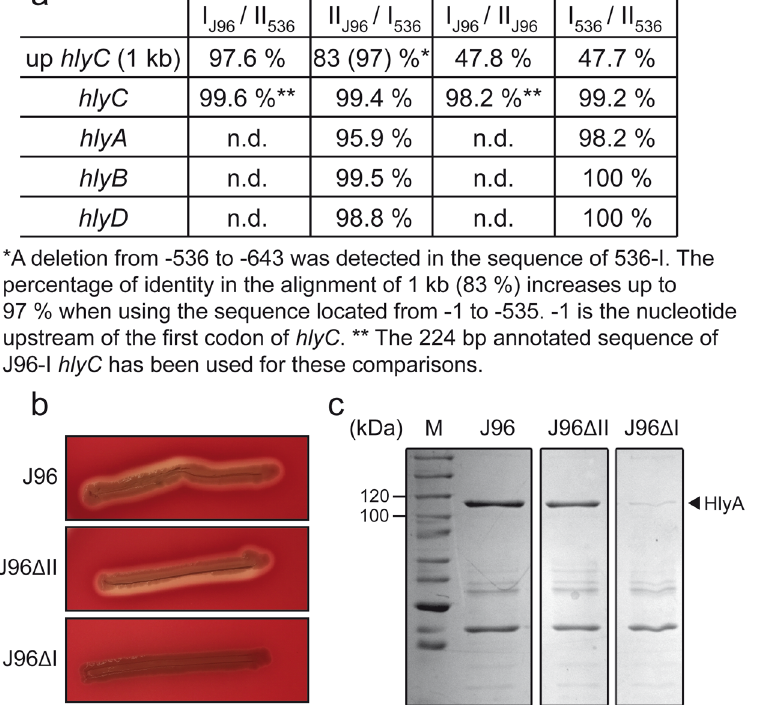
Figure 1. Differential expression of the two hlyCABD operons present in the J96 strain. ( a ) Percentage of identity at the level of the nucleotide sequence between the operon hly I and hly II of J96 and 536. n.d.: not determined. ( b ) Hemolytic phenotype of J96, JFV16 (J96 Δ II) and JFV21 (J96 Δ I) strains on Columbia Blood agar plates. ( c ) Coomassie blue stained SDS-PAGE (10%) of secreted protein extracts from cultures grown in LB 0 at 37 °C up to late-log phase (OD 600 nm of 1.0) of the indicated strains. Lane M: molecular mass markers (size in kDa indicated along the left side). The band corresponding to α -hemolysin (HlyA) is indicated with an arrowhead. Full-length gel image is shown in Fig.